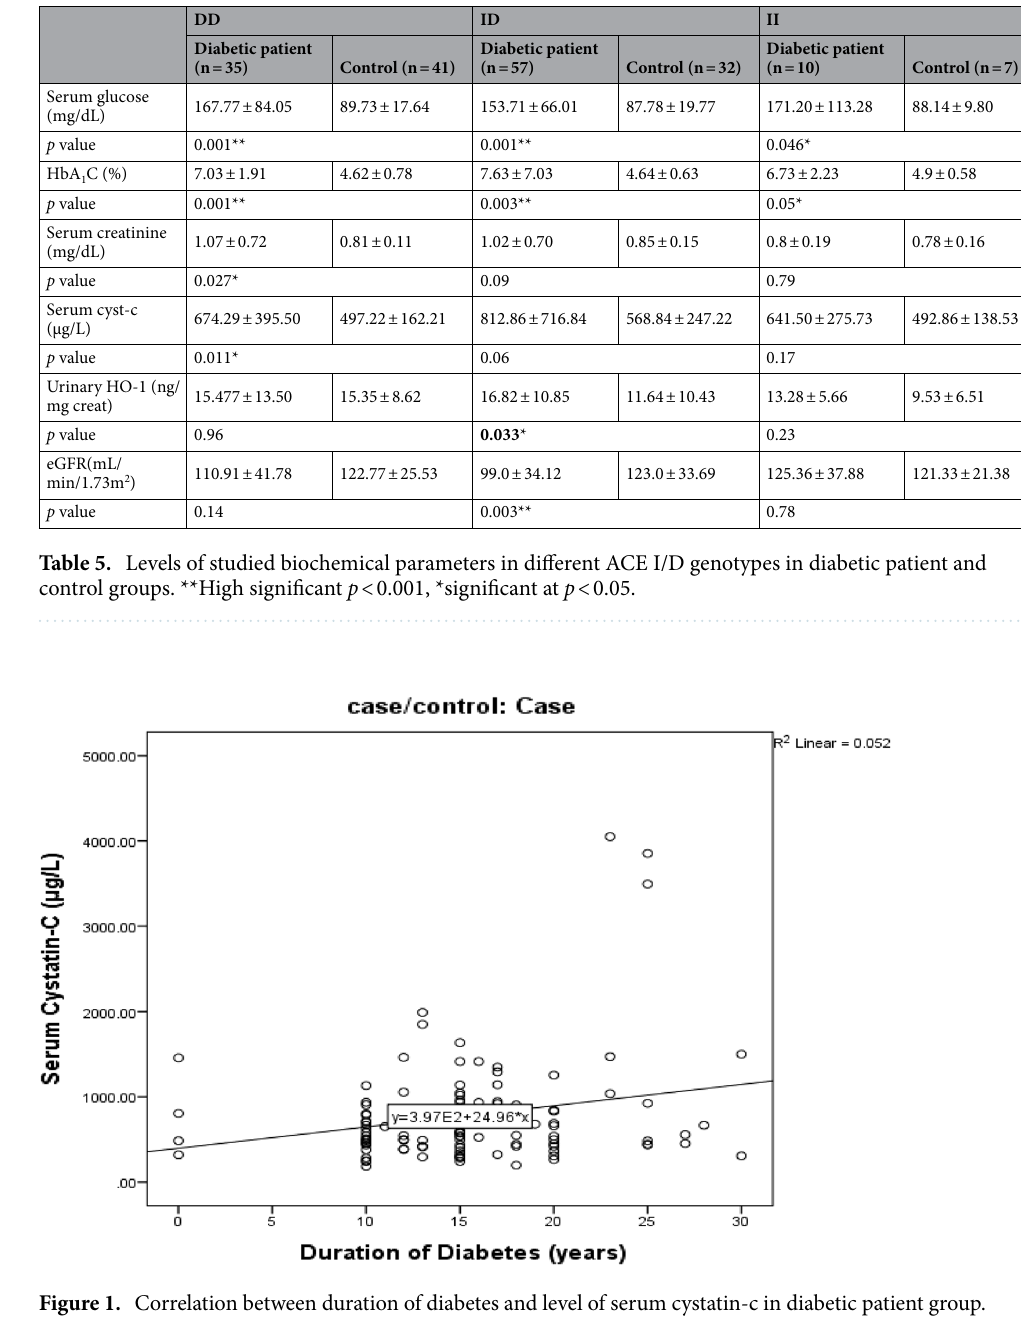
Figure 2 illustrated a significant positive correlation between level of urinary hemeoxygenase and serum glucose in diabetic patient group (r = 0.24, p < 0.02). Figure 3 mentioned that crude area under the ROC curve (AUC) of urinary hemeoxygenase was 0.356, ( p < 0.001) to predict early tubular injury in diabetic kidney, suggesting that urinary HO-1 could represent as potent biomarker of DN in urine. Figure 4 showed that crude area under the ROC curve (AUC) of serum cystatin-c was 0.617, ( p < 0.005) for predicting early tubular injury in diabetic kidney suggesting that serum cystatin-c could be a potential biomarker of DN.